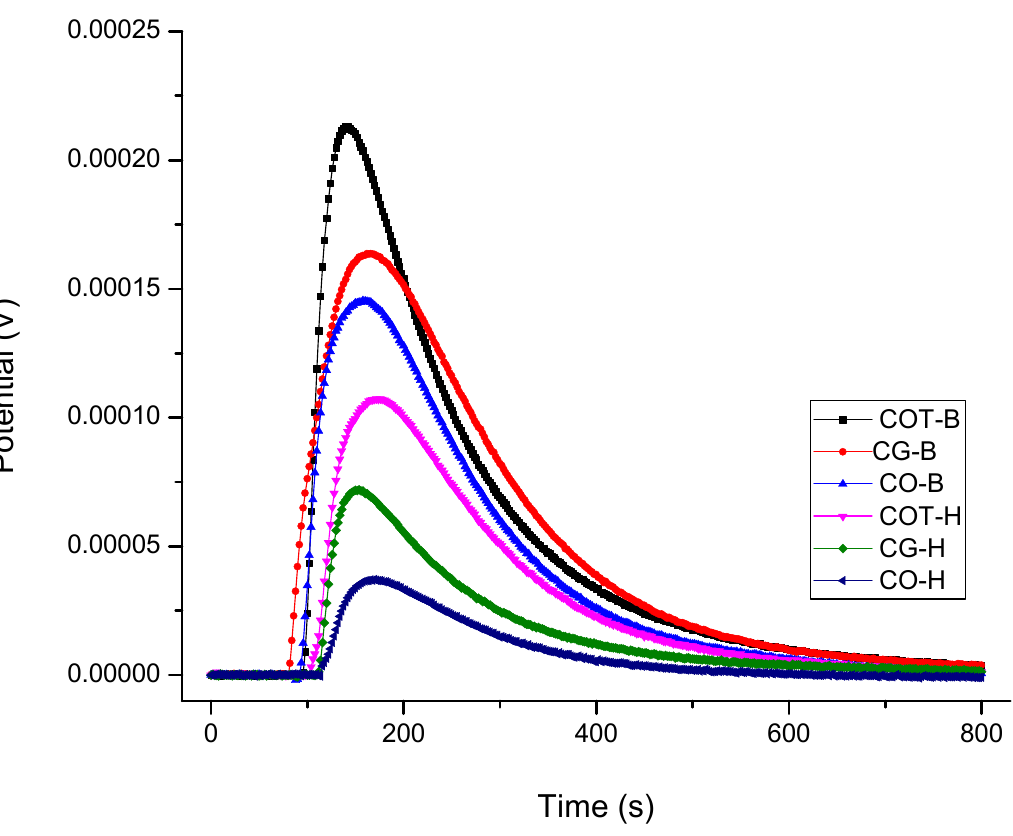
Figure 5. SEM photographs at a different magnification of the CG activated carbon. ( A ) 100 × magnification, ( B ) 1000 × magnification.